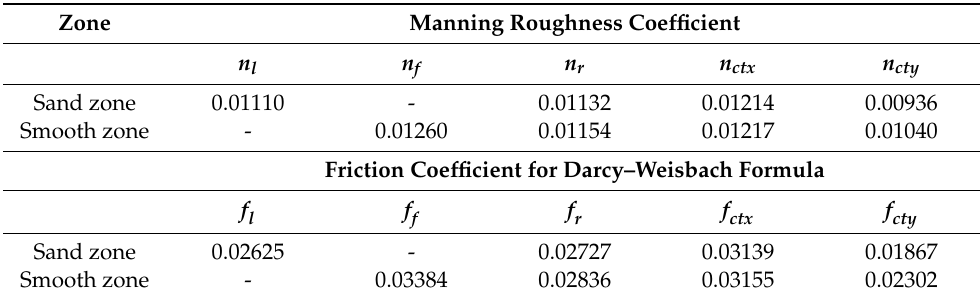
Table 6. The estimated Manning roughness coefficient and friction coefficient for the Darcy–Weisbach formula considering different indirect methods.